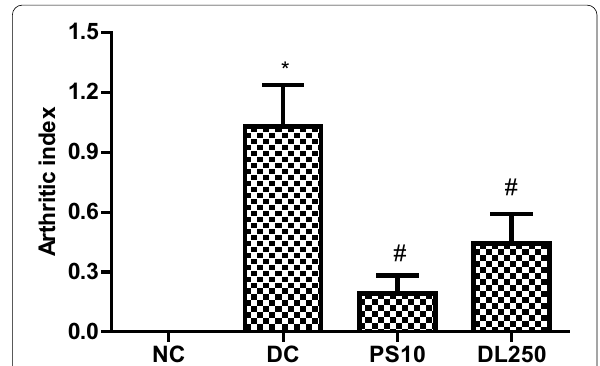
Fig. 3 Effect of C. procera on the arthritic index of CFA-induced arthritic rats. Data represented as mean SEM; * p < 0.05 compared ± to NC group; # p < 0.05 compared to DC group (two-way ANOVA followed by Bonferroni’s post hoc test). NC normal control group, DC CFA-induced arthritic group, PS10 prednisolone-treated group, DL250 dry latex of C. procera -treated group